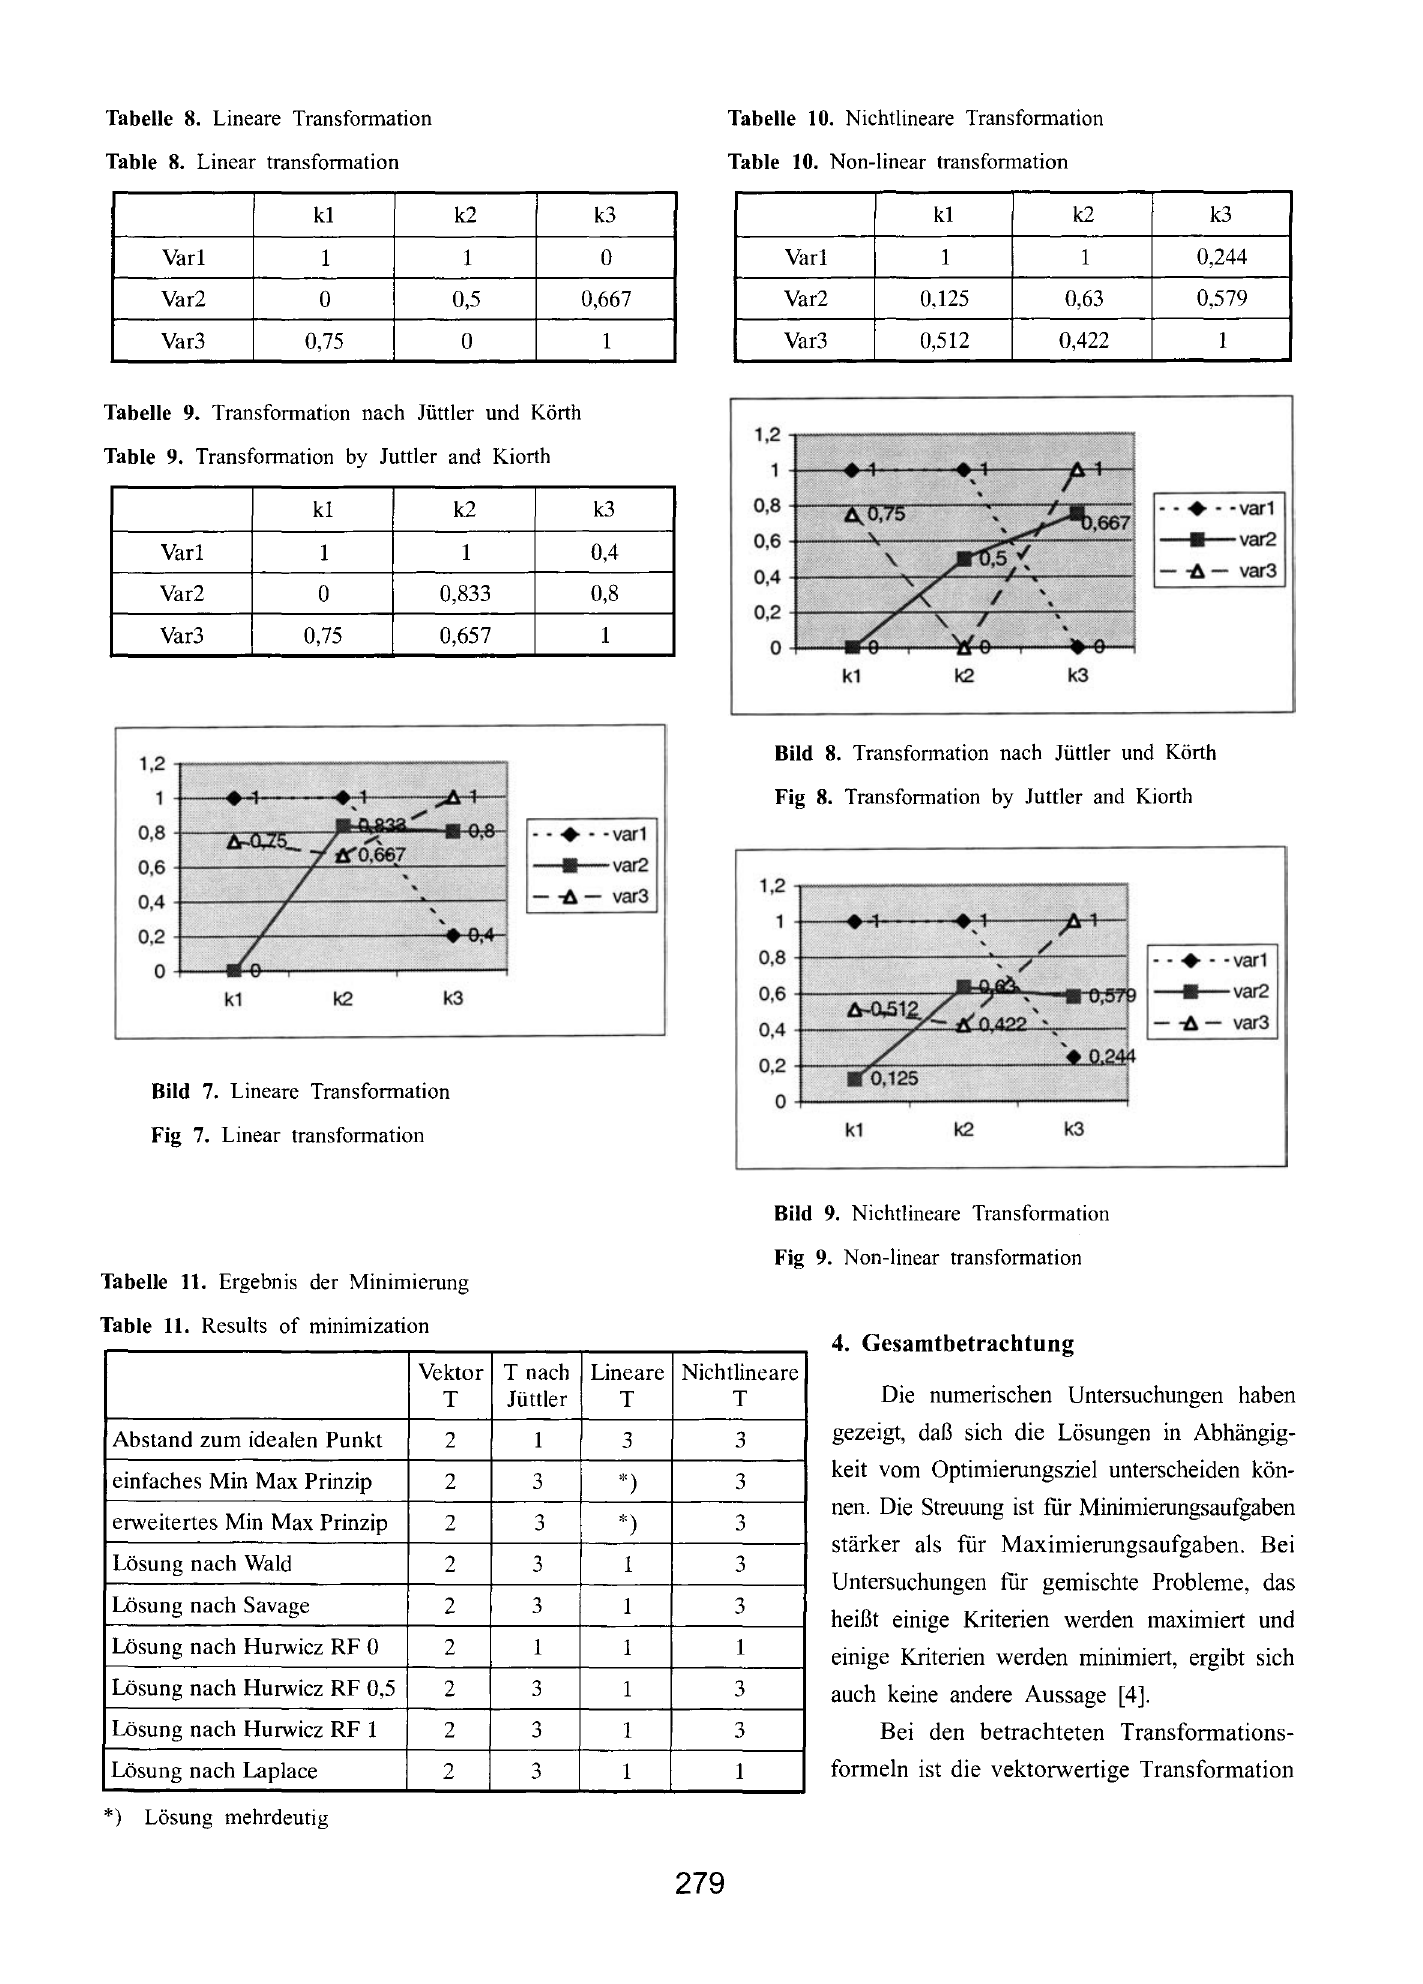
Tabelle 10. Nichtlineare Transformation Table 10. Non-linear transformation